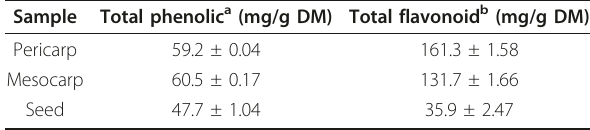
Table 1 Total phenolic and flavonoid contents of different parts of P.macrocarpa